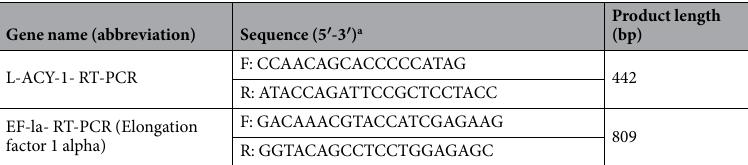
Table 3. Primer pairs used for RT-PCR analysis of the target or reference genes. a F and R respectively indicate forward primer and reverse